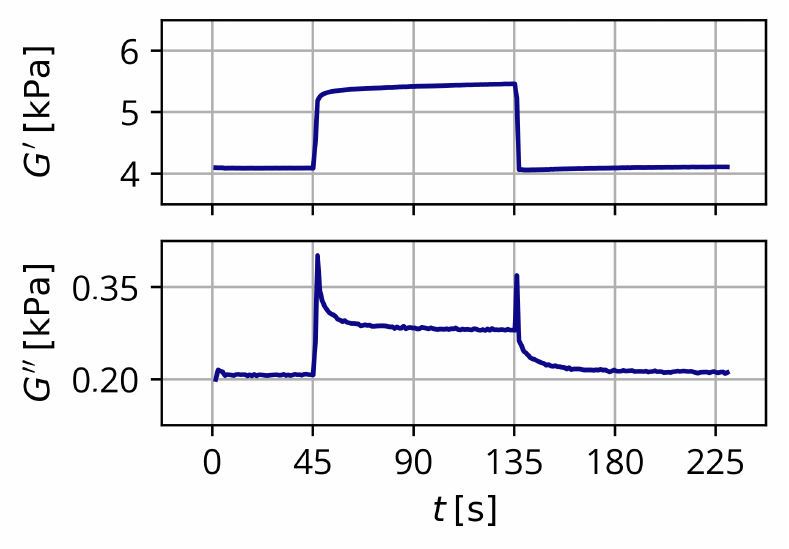
Figure 9. Exemplary measurement curves of the MRE for G (cid:48) and G (cid:48)(cid:48) for a sample with w s = 30%, c NaCl = 0molL − 1 at T =